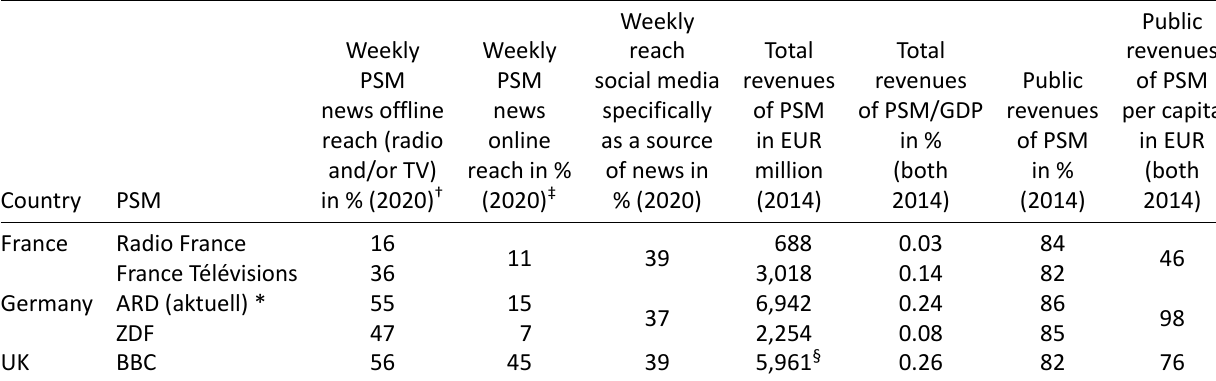
Table 1. Context variables on PSM as well as social media in France, Germany, and the